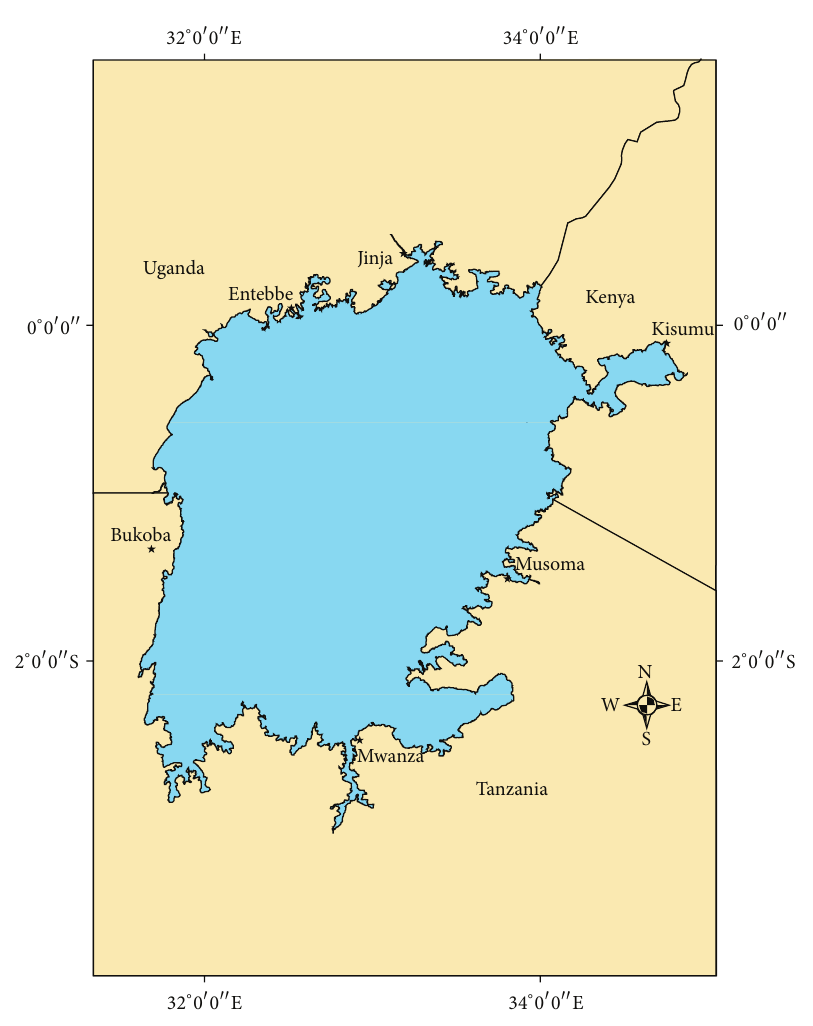
Figure 1: Location of stations used in water balance model.